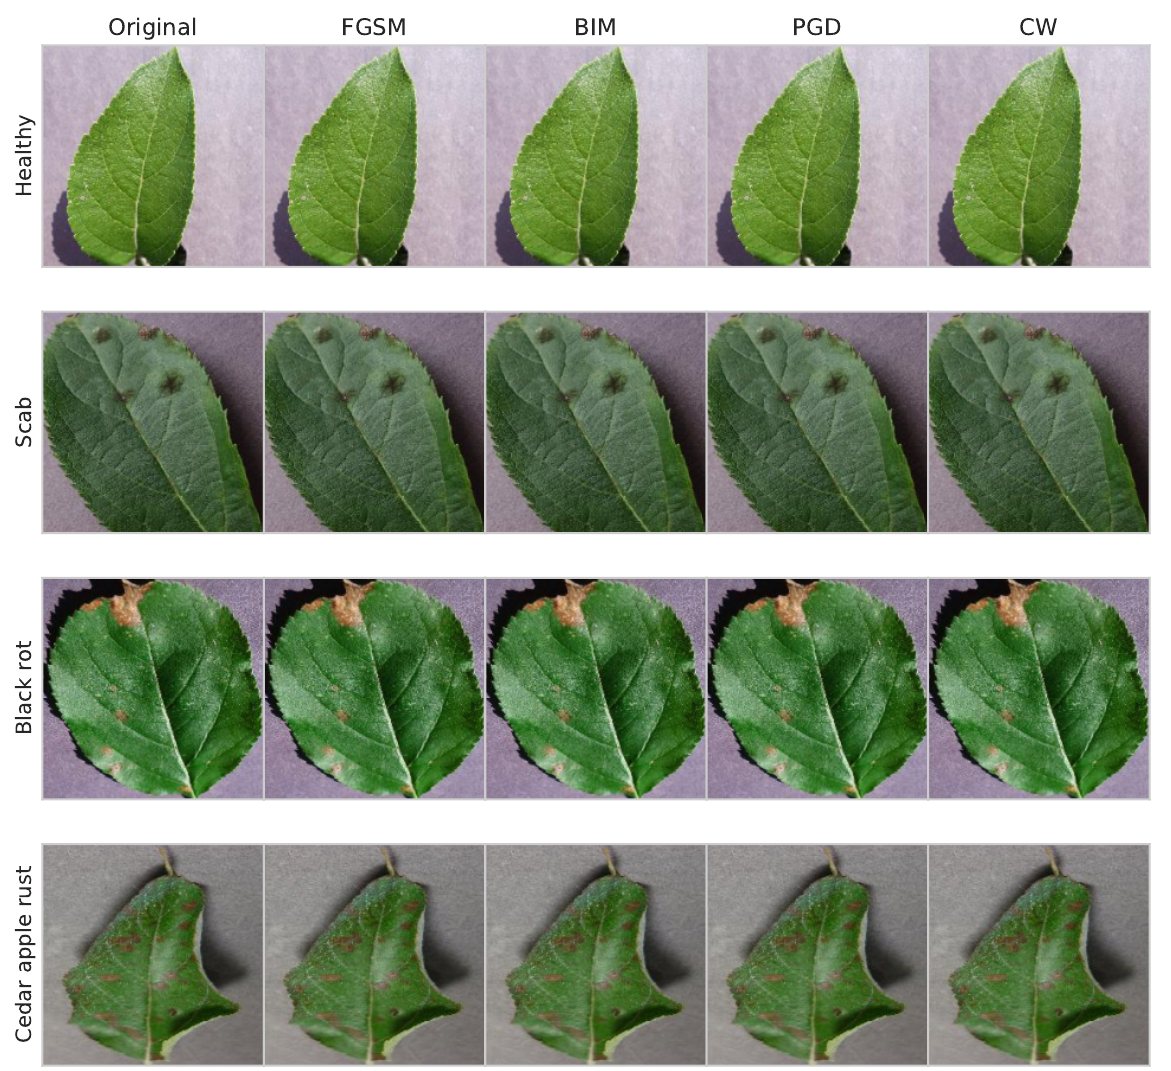
Figure 3. Examples of normal images and adversarial images generated by different attacks (VGG-16, multi-class, (cid:101) =